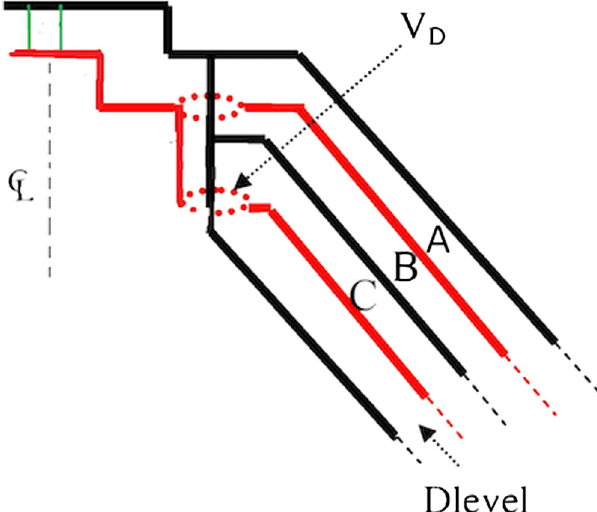
FIG. 1. Schematics of the four vacuum transmission lines (truncated) of the Z machine, denominated levels A, B, C, and D. Anodes are represented by black lines and cathodes by red ones. Currents for the four levels are added up at the post-hole convolute (cathode holes shown in dotted red circles, and anode posts in black). To the left of the post-hole convolute there is a single inner MITL, and the green lines represent the load. V stands for the voltage of one of the post-hole structures at level D. The convolute region goes from about 7 to 11 cm in radius. The vacuum transmission lines extend to a diameter of approximately 3 m. See Refs. [1,2] for detailed